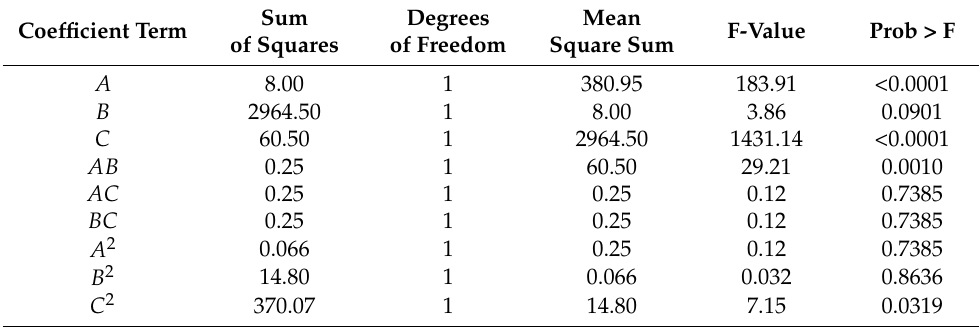
Table 7. The significance test of the coefficient of the quadratic model regression equation.